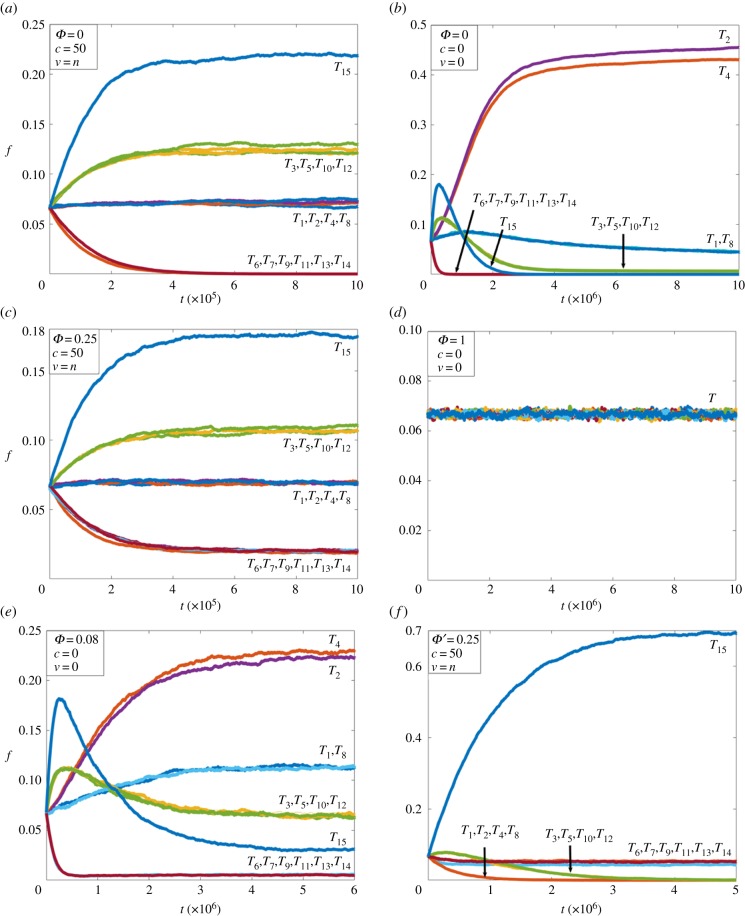
Plots of frequency distributions (f) against iteration time step (t) for interacting populations of automata under different simulated fixed environmental conditions. The simulations show the evolution of six distinct information niches comprising steady-state networks of selected and clustered information processing channels from an interacting population consisting of 90 000 single-state automata distributed at t = 0 equally across 15 different types (shown in different colours) and subjected to three different environment inputs. (a) Niche A: population production dynamics in an environment with high spatial mixing of automata (1 ≤ c ≤ N, 1 ≤ v ≤ n) and with no influx of randomly generated automata (Φ = 0) showing extinction of six automaton types and the emergence of a steady-state distribution of nine survival types arranged into three distinct clusters with one, four or four members after t = 4 × 105 time steps. (b) Niche B: extinction and steady-state survival of 11 and four binary automaton types, respectively, under a highly immobile environment exhibiting no diffusivity (c = 0, v = 0) and no randomly generated influx (Φ = 0). The survivors are arranged in three sub-groups containing one, one or two members. (c) Niche C: population production dynamics across a range of mixing conditions (0 ≤ c ≤ N, 0 ≤ v ≤ n) and subjected to a considerable rate of influx of randomly generated automata (0.25 ≤ Φ ≤ 0.9). All automaton types survive to produce a heterogeneous population structure comprising four steady-state clusters consisting of one, four, four and six members. The population is structured similarly to niche A except that six members no longer become extinct. (d) Niche D: under all mixing conditions (0 ≤ c ≤ N, 0 ≤ v ≤ n) and with Φ
> 0.9 the population dynamics are dominated by the influx of new randomly generated automata from the environment such that the population remains unstructured and compositionally homogeneous over 1 × 105 iterations. (e) Niche E: with no diffusive mixing on the lattice (c = 0, v = 0) and with a very low influx rate (0 < Φ < 0.1); the population is structurally similar to niche B except that three sub-groups of automaton types ((T15), (T3,T5,T10,T12) and (T6,T7,T9,T11,T13,T14)) no longer go extinct. (f) Niche F: with restricted automaton influx (Φ′ = 0.25) and under a range of mixing conditions (0 ≤ c ≤ N, 0 ≤ v ≤ n) the population evolves to three groups of automata (T15), (T6,T7,T9,T11,T13,T14) and (T3,T5,T10,T12), with the group (T1,T2,T4,T8) going extinct.